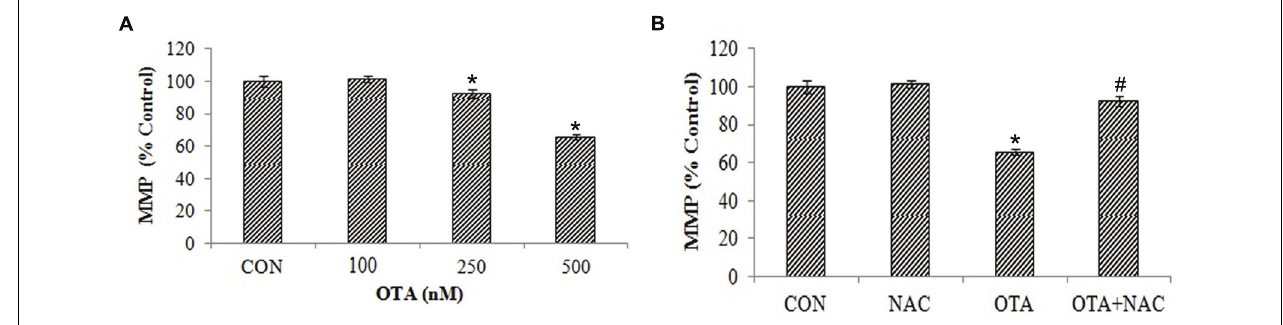
FIGURE 5 | NAC reversed the mitochondrial membrane potential (MMP) loss induced by OTA treatment in Neuro-2a cells. (A) Neuro-2a cells were treated without or with various concentrations of OTA (100–500 nM) for 24 h and MMP loss was quantified as fluorescence (B) . Neuro-2a cells were pretreated with